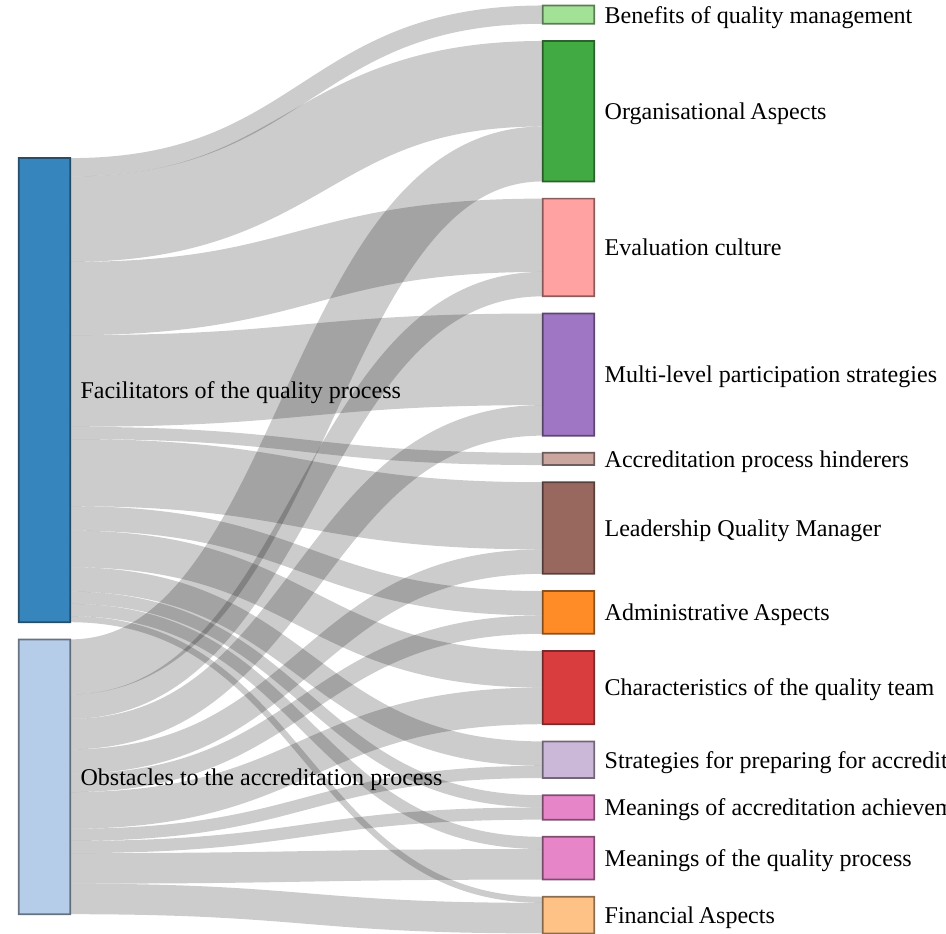
Figure 1. Graphical representation of the facilitating and hindering